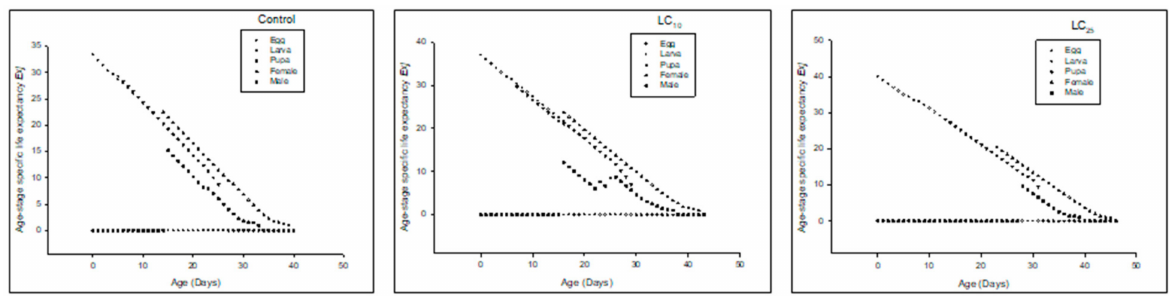
Figure 7. Age stage-specific survival rate ( s xj ) of the F 2 generation in Spodoptera frugiperda . The e xj was higher in LC 10 and LC 25 -treated insects than in the control (Figure 8).